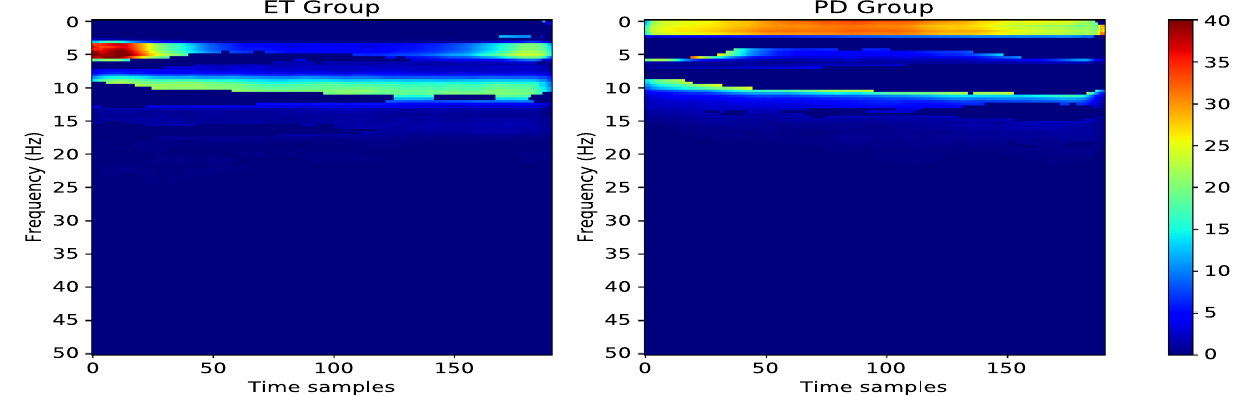
Figure 7. Results of the statistical test over the Grad-CAM analysis of NeurDNet for the two diseases. The intensity of different parts in the spectrogram determines the importance of the region for NeurDNet to conclude the class of the tremor